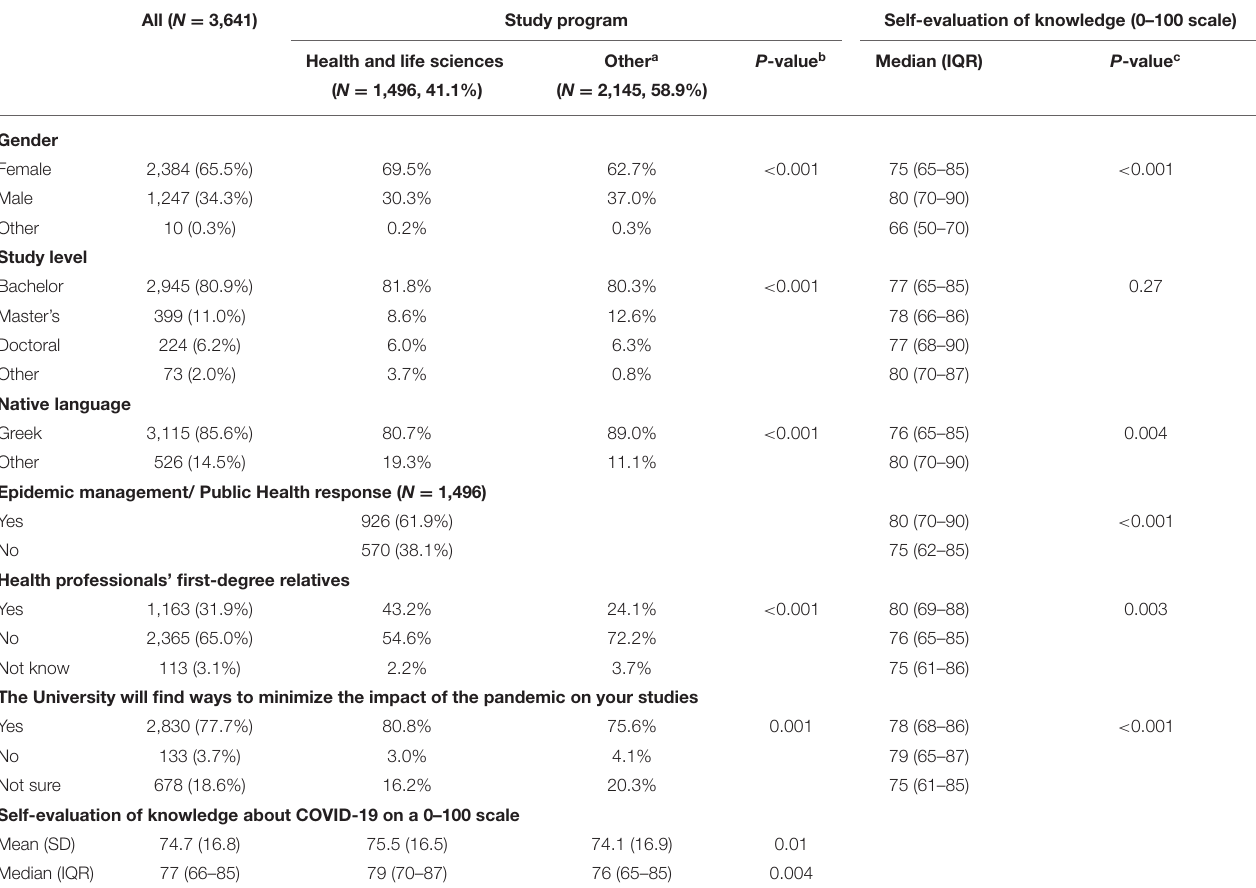
TABLE 1 | Sociodemographic characteristics of the participants and self-evaluation of the level of knowledge about new coronavirus/COVID-19 across five universities and according to study program ( N = 3,641, listwise complete responses). All ( N =